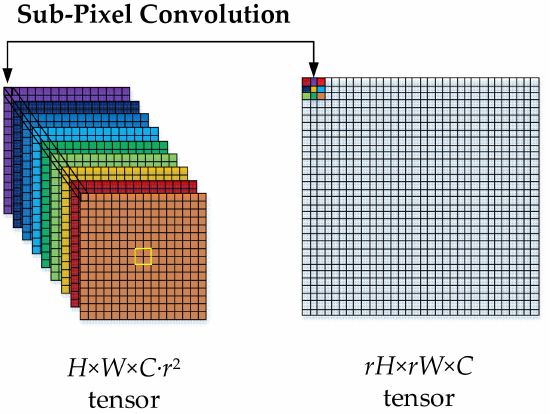
Figure 6. Schematic of the sub-pixel convolution operation. The sub-pixel convolution rearranges the tensor with dimensions of H × W × C · r 2 to rH × rW × C